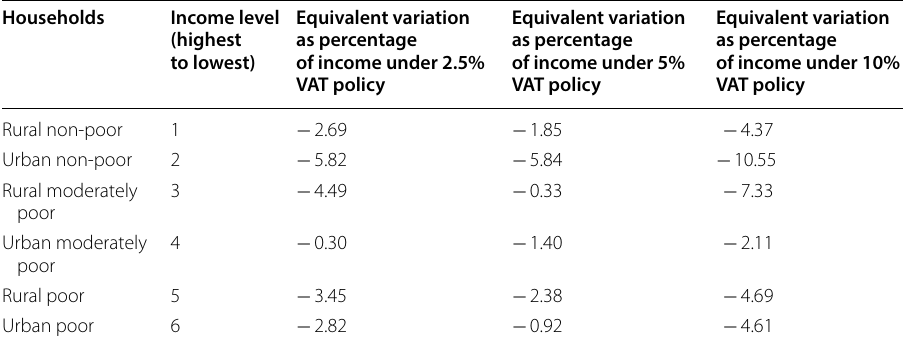
Urban moderately poor Rural poor